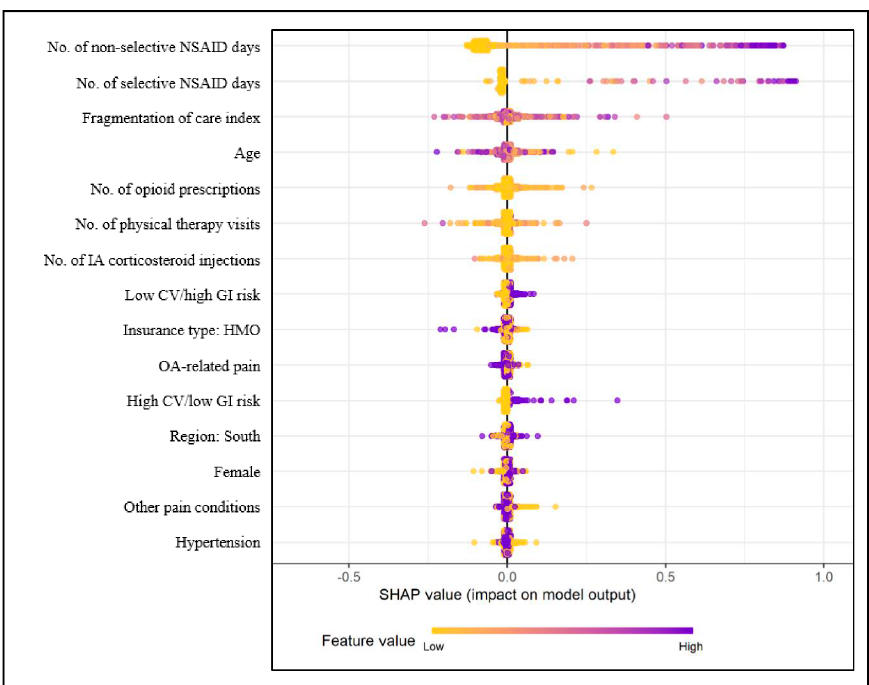
Figure 3. Variable Importance and SHAP Summary Plot for Potentially Inappropriate NSAIDs Use. Note: Based on 44,990 older adults (age > 65) with OA using data from Optum De-identified Clinformatics ® Data Mart who were continuously enrolled in Medicare Advantage plan during 2015–2016. The x-axis represents the marginal contribution of a feature to the change in predicted probability of NSAIDs use. Feature value refers to the actual value of the predictors (e.g., values for no. of non-selective NSAIDs days will range from 0 to 365 with values closer to 0 represented with yellow and values closer to 365 represented with purple dots). CV—cardiovascular, GI—gastrointestinal, HMO—health maintenance organization, NSAID—non-steroidal anti-inflammatory drug, OA—osteoarthritis, SHAP—Shapley Additive exPlanations.